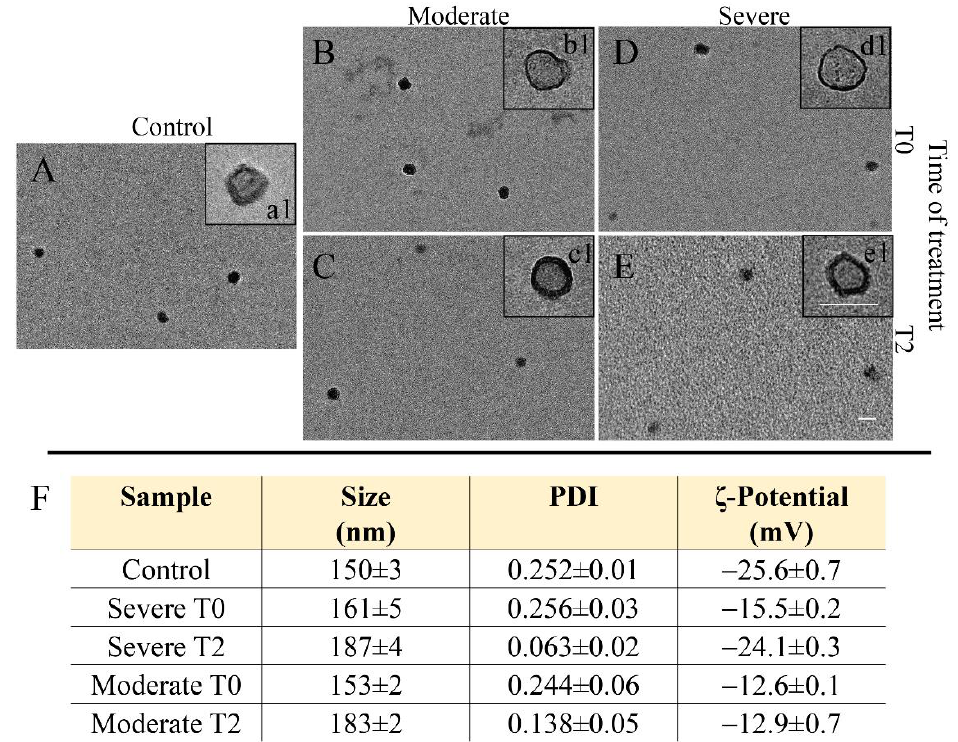
Figure 1. Exosomes freshly extracted from plasma of healthy subjects (20) and NAFLD-affected patients (95, 56 males and 39 females) with moderate (38) or severe (57) hepatic steatosis at recruitment time (T0) and after treatment (T2): representative TEM micrographs obtained with staining, for two increasing staining times, namely, 30 (a1 – e1) and 60 s ( A – E ) (scale bar 100 nm); intensity-average hydrodynamic diameter and corresponding polydispersity index (PDI) determined by DLS and ζ -potential value. Mean ± SD are reported, n = 3 ( F ).